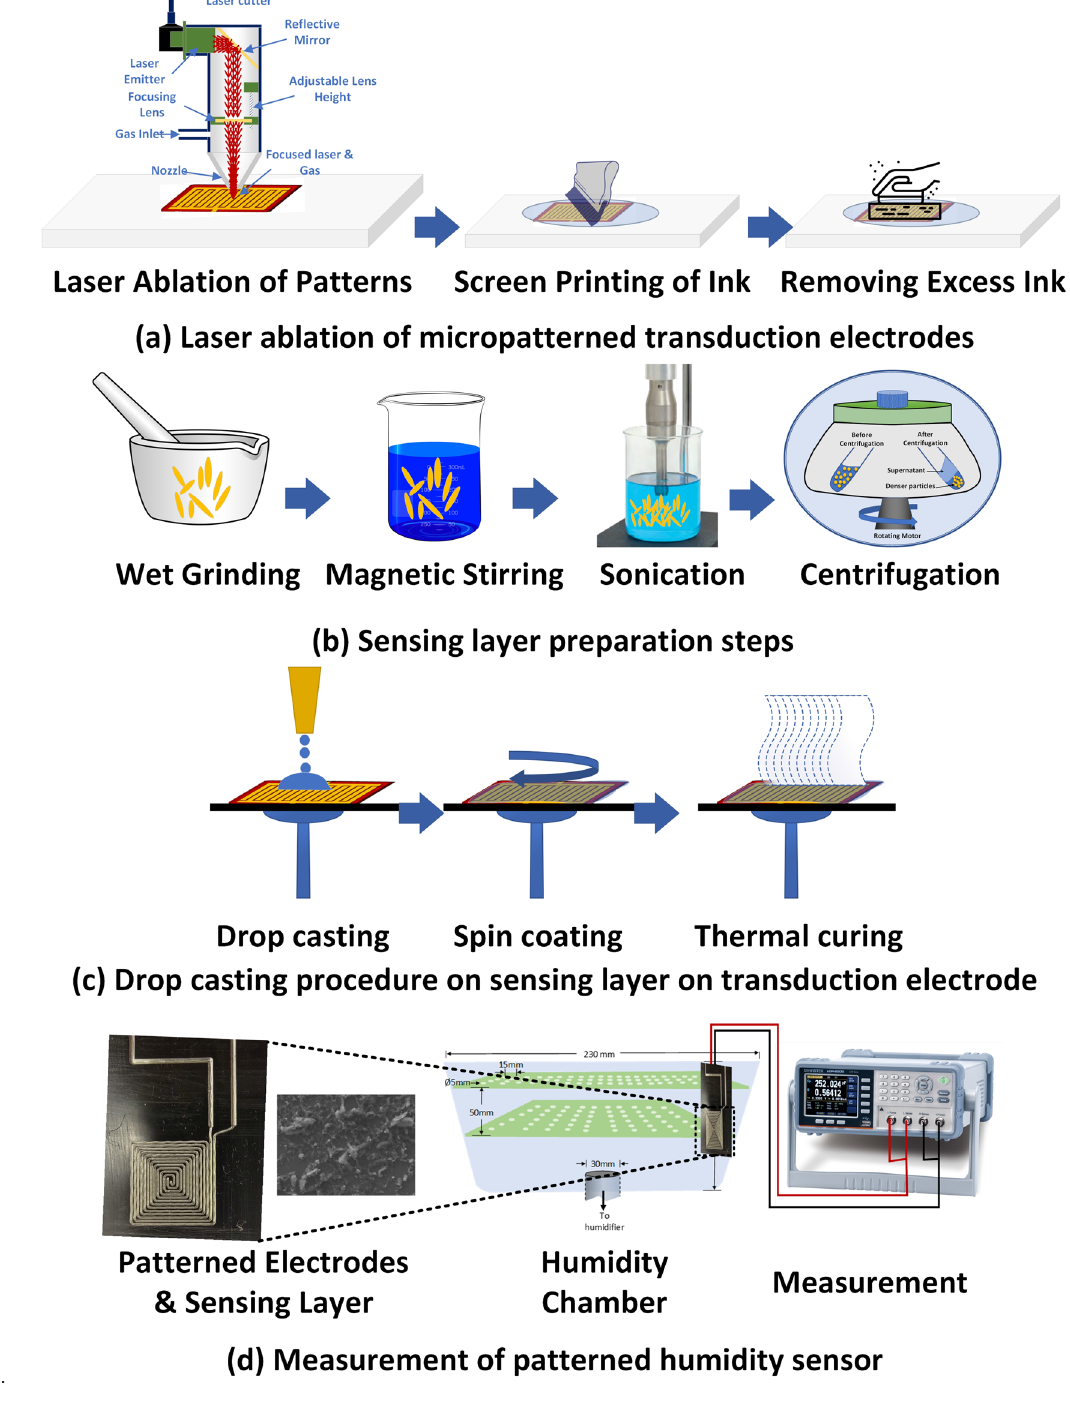
Figure 2. Steps for laser ablated micropatterned sensor